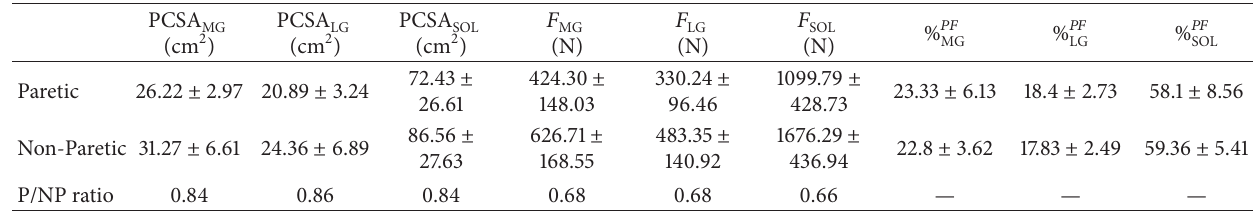
Table 3: PCSA, force contributions ( 𝐹 𝑚 ) and percentages of overall plantar flexor torque ( ±